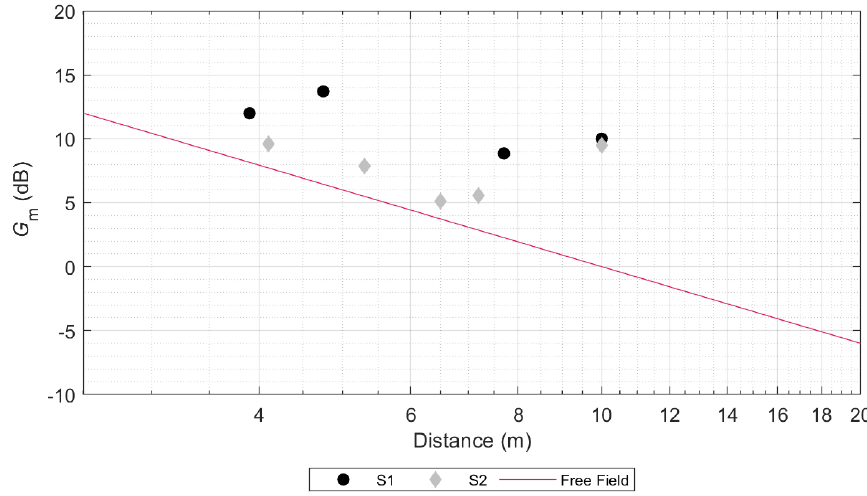
Figure 9. Sound strength, G m (dB), spectrally averaged values calculated from the measured IR at Bacinete III. The theoretical free field propagation is represented by the red line.